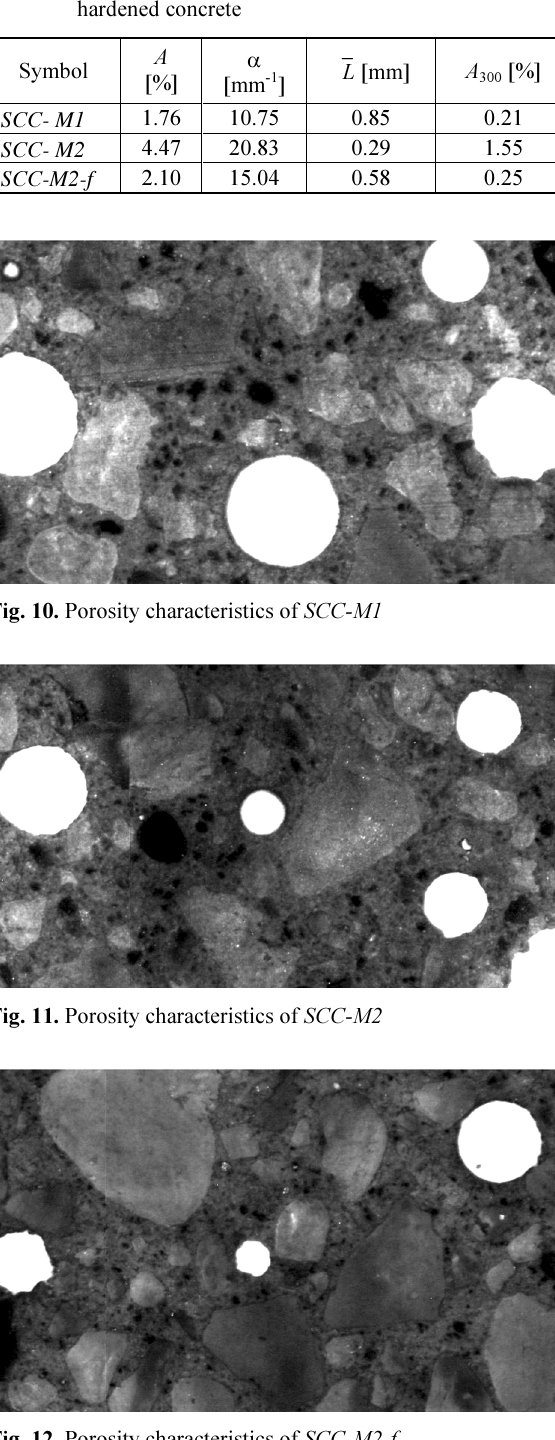
Fig. 12. Porosity characteristics of SCC-M2-f